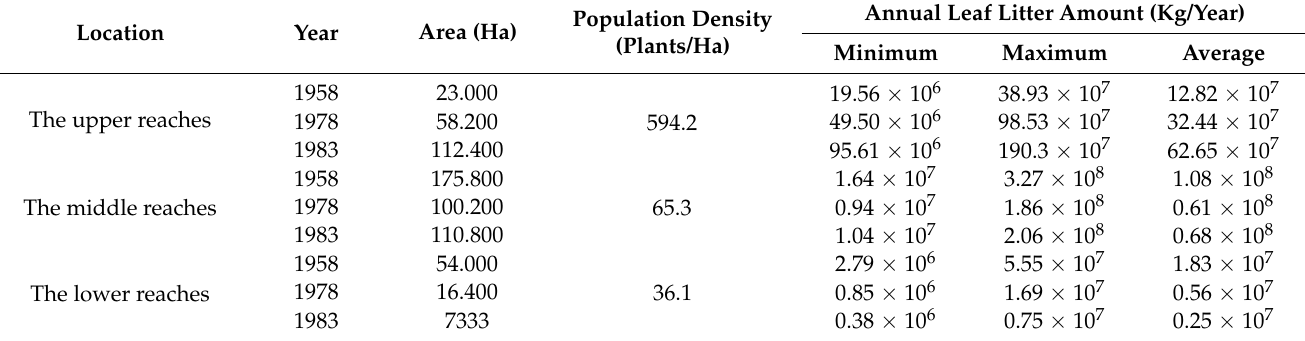
Table 4. Annual leaf litter amount of P. euphratica forest in different reaches along the main channel of the Tarim River